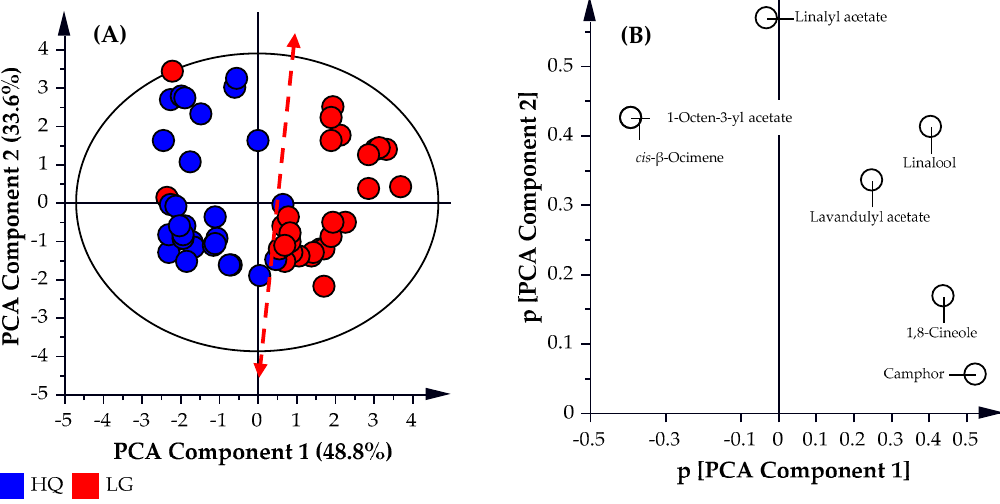
Figure 2. ( A ) PCA Scatter plot and ( B ) PCA Loadings Scatter Plot of the analyzed samples by targeted GC-MS.